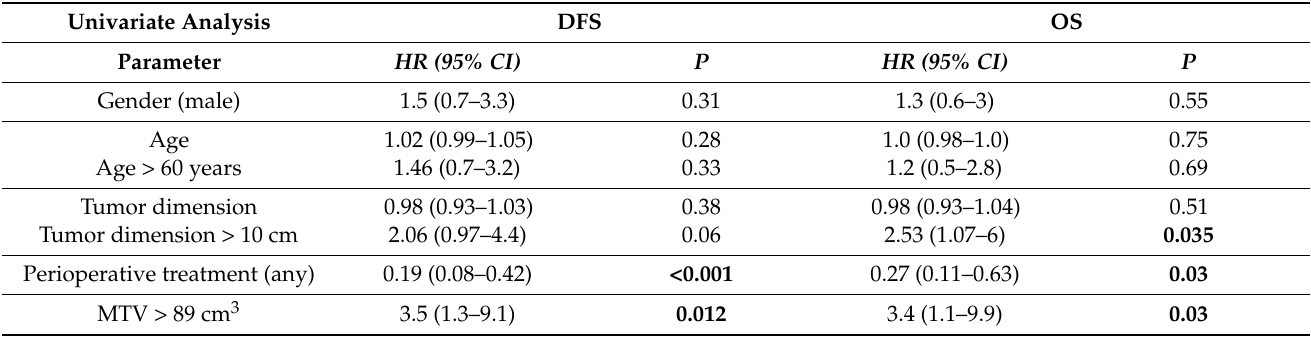
Table 3. Univariate and multivariate Cox proportional-hazards regression for the prediction of DFS and